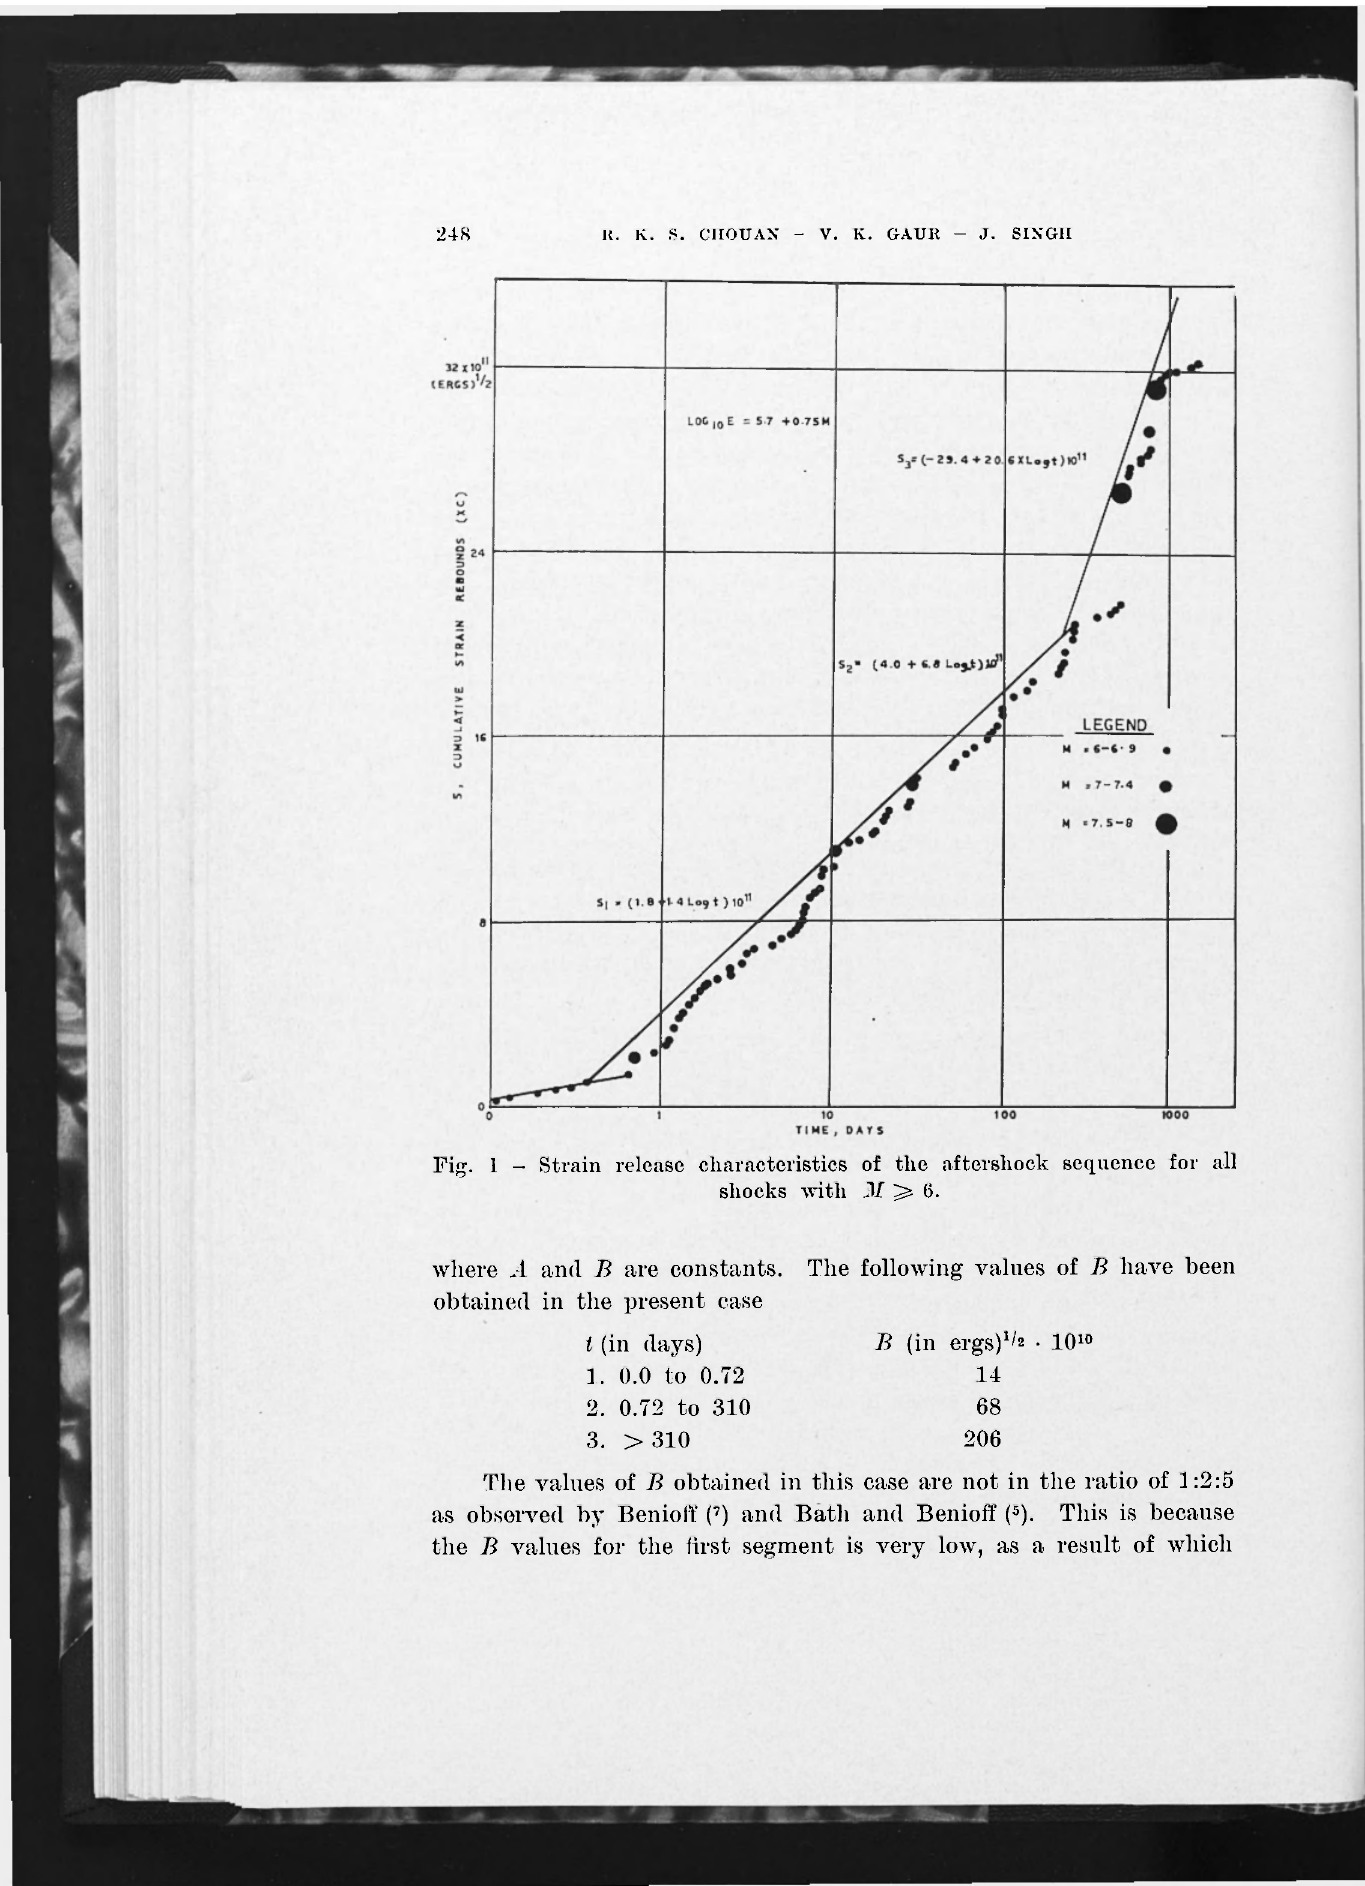
Pig. 1 - Strain release characteristics of the aftershock sequence for all shocks with M ^